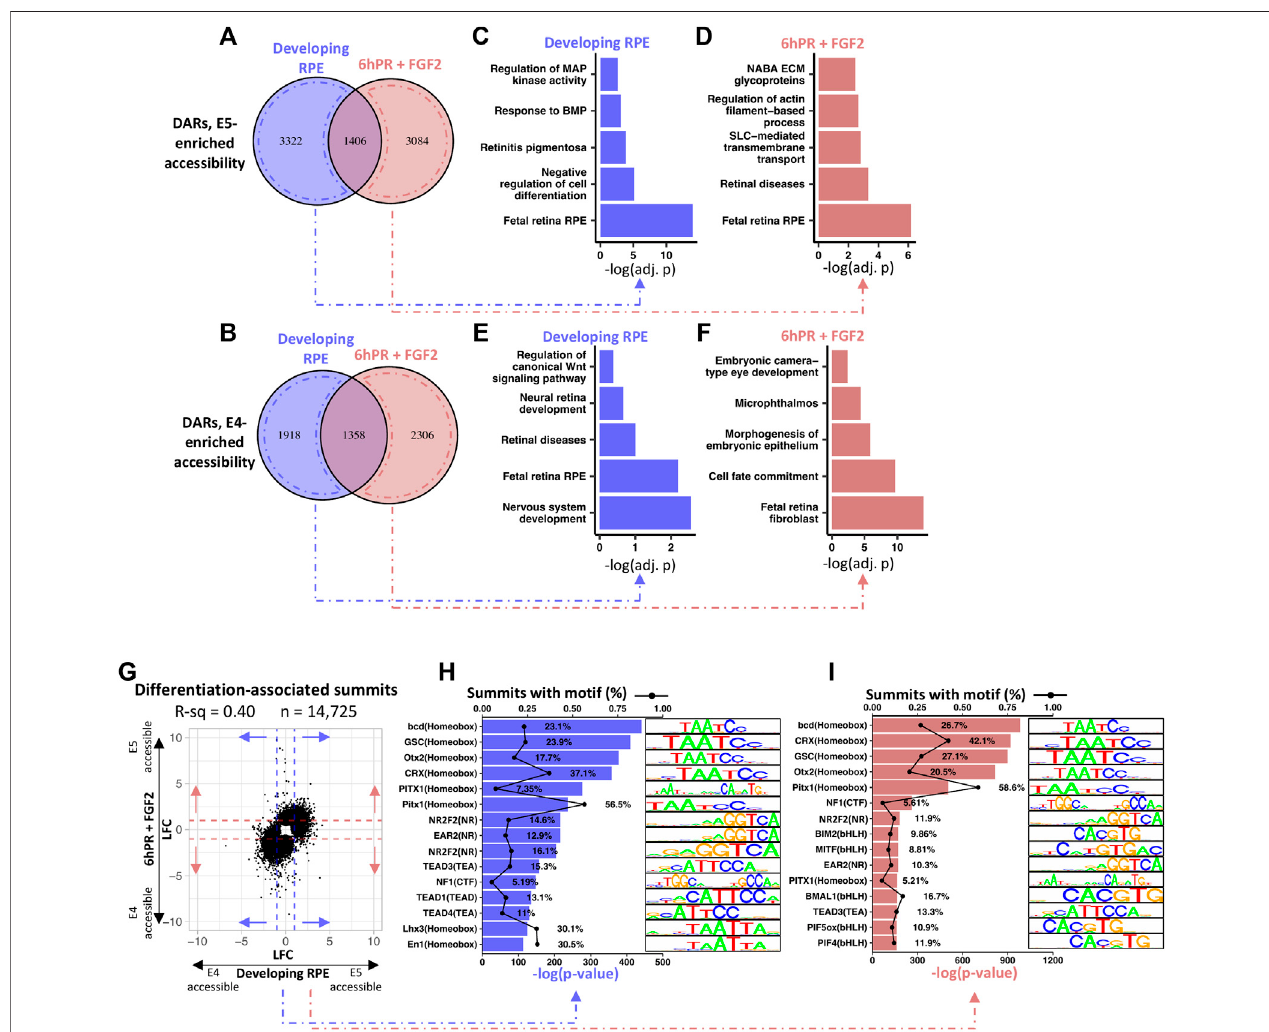
FIGURE 6 | RPE maturation is accompanied by differential accessibility at retinal development genes and homeobox transcription factor binding sites. (A) Venn diagramsummarizestheoverlapofup-regulatedDARs(DARswithincreasedE5accessibility)betweenthedevelopingand6hPR+FGF2conditions,de fi nedbyacut-off of Adj. p -value ≤ 0.05. (B) Similarly, Venn diagram displays down-regulated DARs (E4-enriched DARs) for the two conditions. DARs unique to either condition were annotated to the nearest gene TSS within 10 kilobases, and pathway enrichment analysis was performed for DARs enriched in the developing E5 RPE (C) , the E5 6hPR +FGF2 RPE (D) , the developingE4 RPE (E) , or theE4 6hPR + FGF2 RPE (F) . (G) The log foldchange(LFC) ofdifferentially accessible peak summits between the E4 and E5 conditions are plotted. Dashed lines represent a LFC cut-off of 1 that was used to select summits for motif analysis. HOMER motif detection software was used toidentifytranscriptionfactor DNAmotifs overrepresentedinthesummitsofpeaks differentiallyaccessible acrossthe developing (H) or 6hPR+FGF2 (I) RPE,and the top 15 enriched motifs are shown.